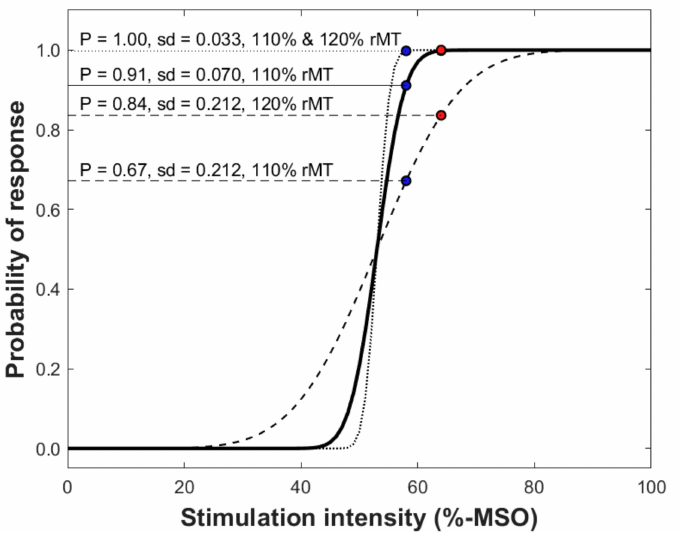
Figure 6. Demonstration of the cumulative distribution function representing the probability of inducing a response at different SIs. As the slope, represented as relative spread [110], can differ between subjects, the use of the SI related to the rMT can induce differences to the absolute size of the motor map [25]. In the plot, mean relative spread ( solid black line ) and the minimum ( dotted black line ) and maximum ( dashed black line ) found in the study population were used to compare probabilities of inducing a response at 110% rMT ( blue dots ) and 120% rMT ( red dots ). At a low relative spread, 110% and 120% rMT produce an MEP at the stimulation target with a probability close to 100%, but with the high relative spread, the probabilities of MEPs at the target at 110% and 120% rMT are 68% and 83%,